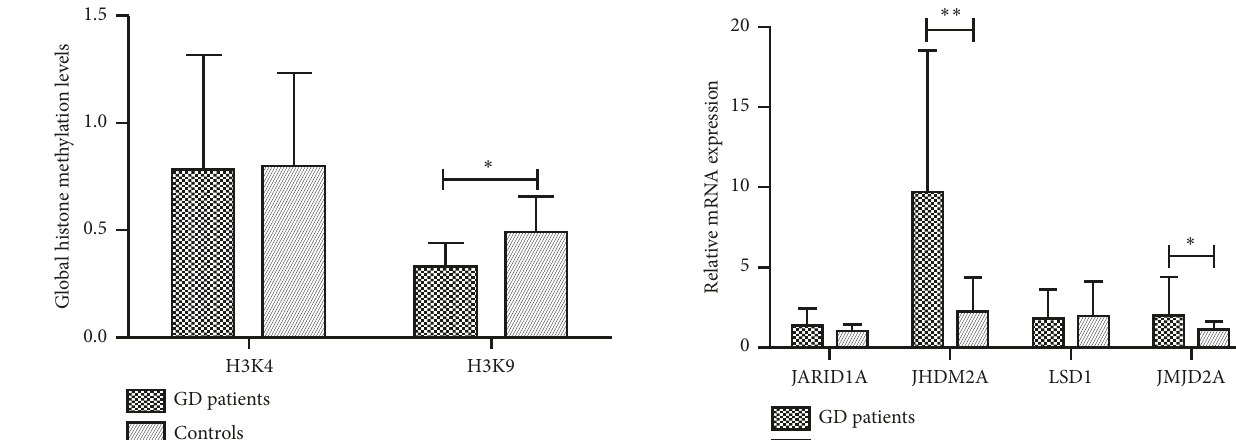
1.969 ± 2.428 vs. 1.117 ± 0.527 for JMJD2A, P=0.007, Figure